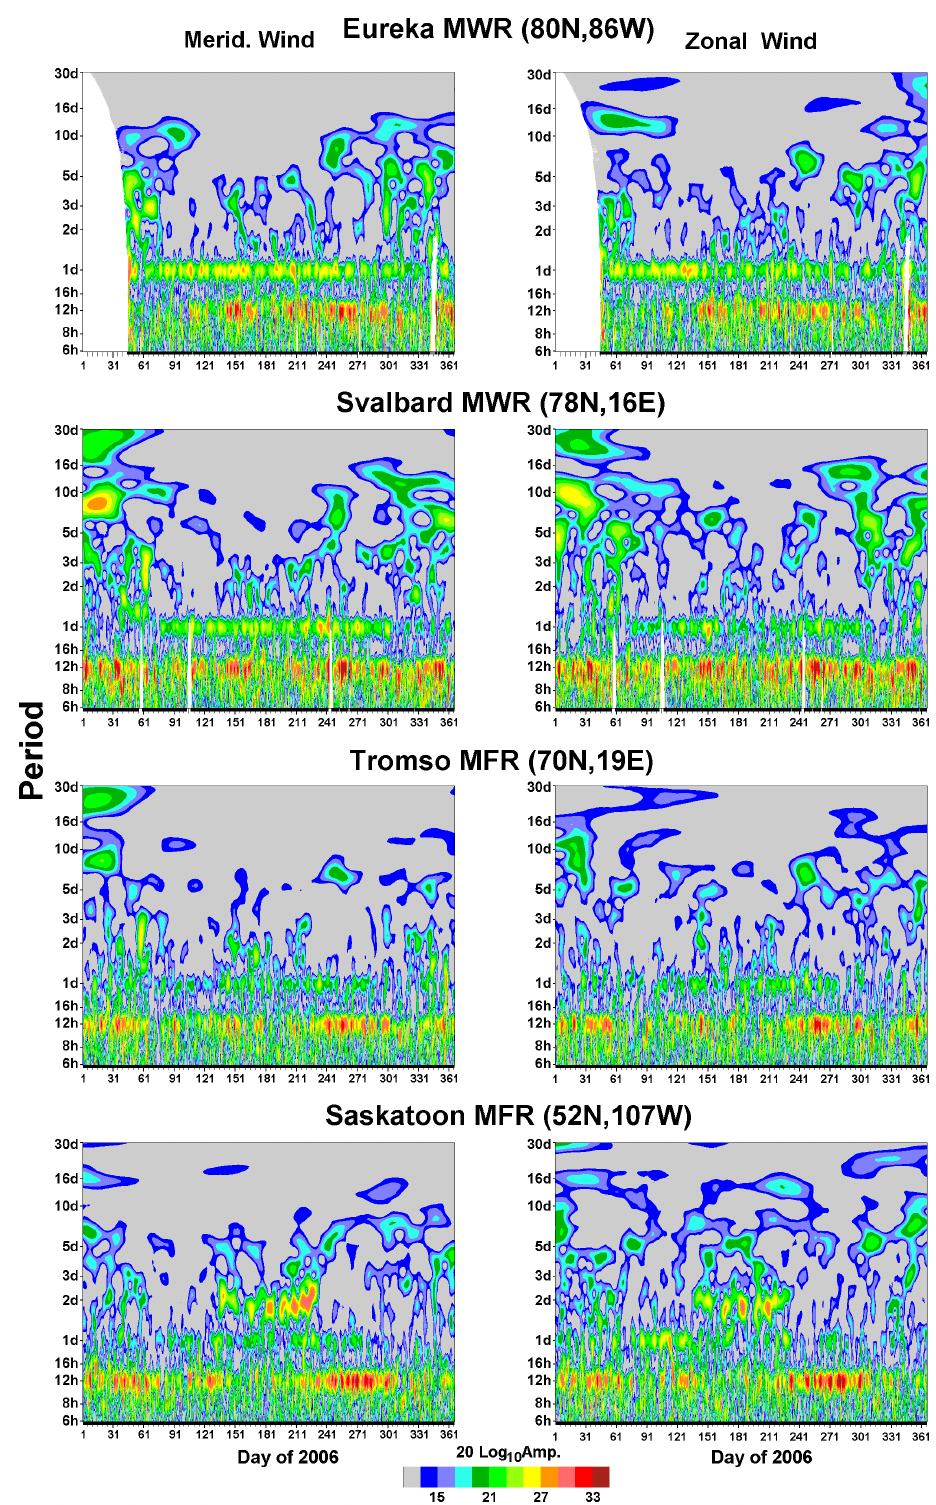
Fig. 13. Wavelet analyses applied to winds data from the two Arctic radars, Tromso and Saskatoon. The analysis method is described fully in Manson et al. (2005). The dominance of the semidiurnal tide at Svalbard and the diurnal tide at Eureka is clearly evident. Planetary wave activity is relatively strong in the